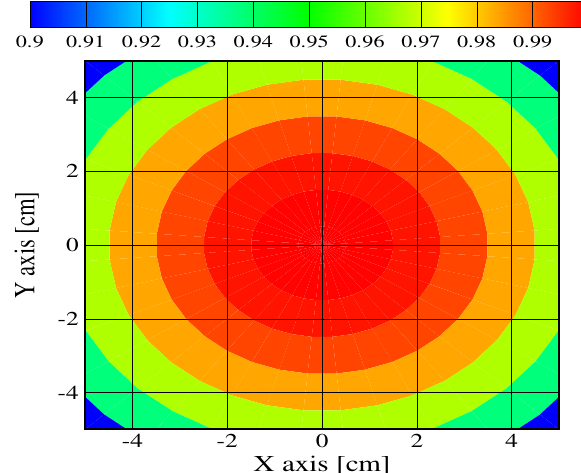
Figure 8. Contours of normalized radiative flux density on a 10 cm × 10 cm sample located at 2.5 cm below the